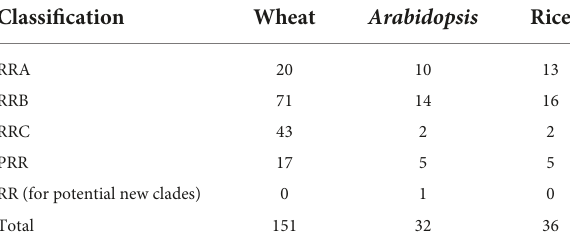
TABLE 1 Summary of the RR superfamily in wheat, Arabidopsis , and rice.